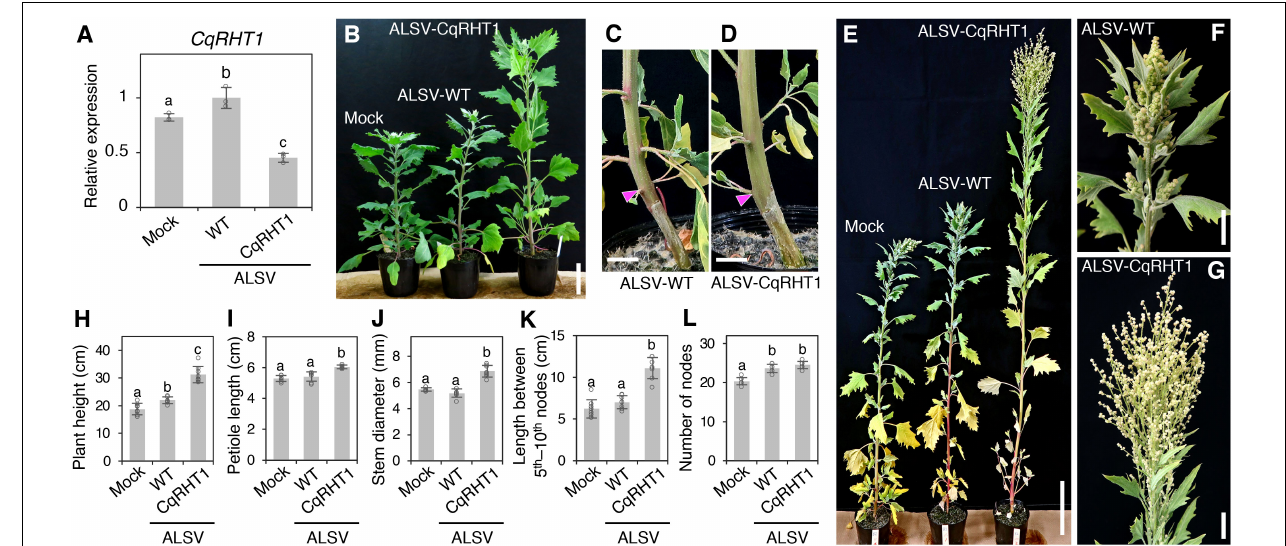
FIGURE 4 | Knockdown of CqRHT1 causes an overgrowth phenotype in quinoa. (A) RT-qPCR quantification of CqRHT1 transcripts in the uninoculated upper leaves of the quinoa inbred line J082 inoculated with mock buffer, ALSV-WT, and ALSV-CqRHT1. Data were normalized to CqUBQ10 expression and are shown as means ± SD ( n = 3). (B–G) Representative images of plants inoculated with mock buffer, ALSV-WT, and ALSV-CqRHT1 at 21 (B) , 28 (C,D) , and 37 (E–G) dpi. Whole plants (B,E) , stem (C,D) , and inflorescence (F,G) are shown. Arrowheads in (C) and (D) indicate the position at the first node. Scale bars represent 5 cm (B) , 1 cm (C,D) , 10 cm (E) , or 2 cm (F,G) . (H–L) Statistical analysis of the growth of quinoa plants inoculated with mock buffer, ALSV-WT, and ALSV-CqRHT1. Plant height (H) , petiole length of the eighth leaf (I) , stem diameter at the first node (J) , internode length between the 5th and 10th nodes (K) , and number of nodes (L) were measured at 20 dpi. The data are presented as means ± SD ( n = 8). Different letters in (A,H–L) indicate significant differences by a Tukey’s HSD test ( p < 0.05).